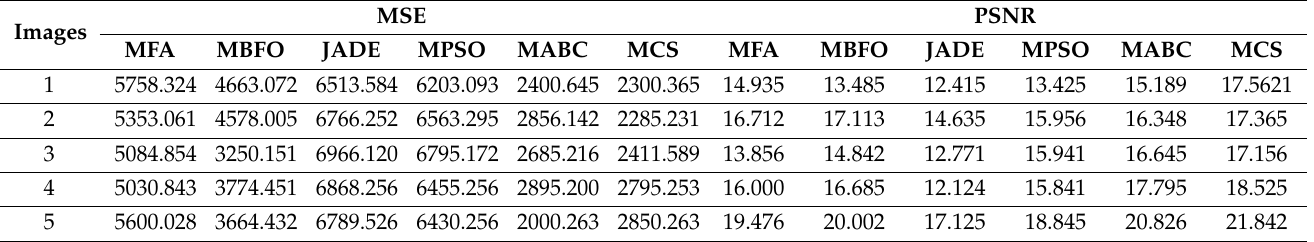
Table 5. MSE and PSNR using different optimization algorithms with minimum cross entropy.